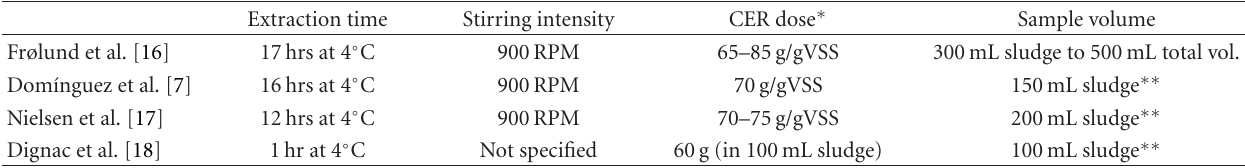
Table 1: Di ff erent experimental conditions applied for EPS extraction in the cation exchange resin